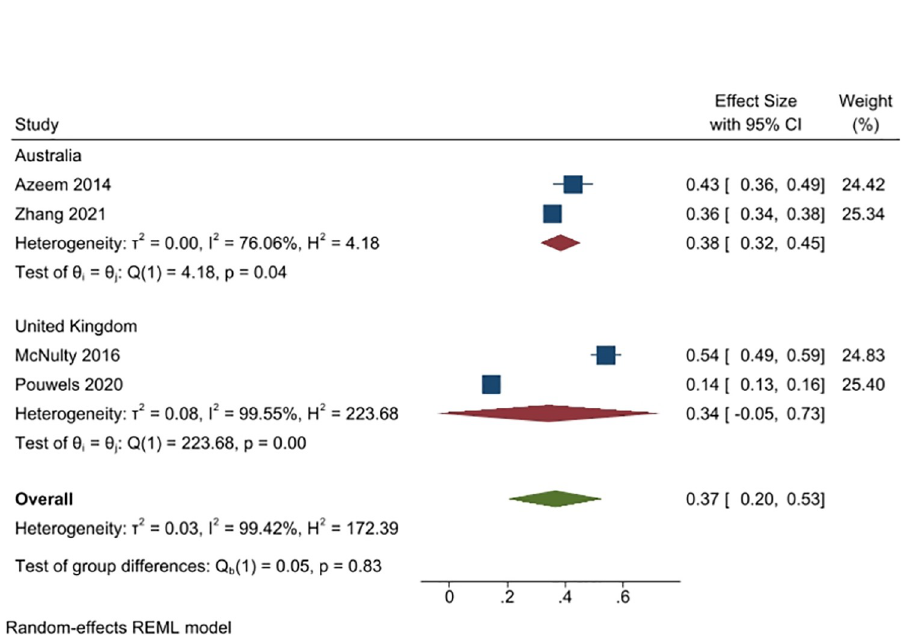
Fig 4. Percentage of respondents answering yes to the question of whether they took or administered an antibiotic for a viral infection.